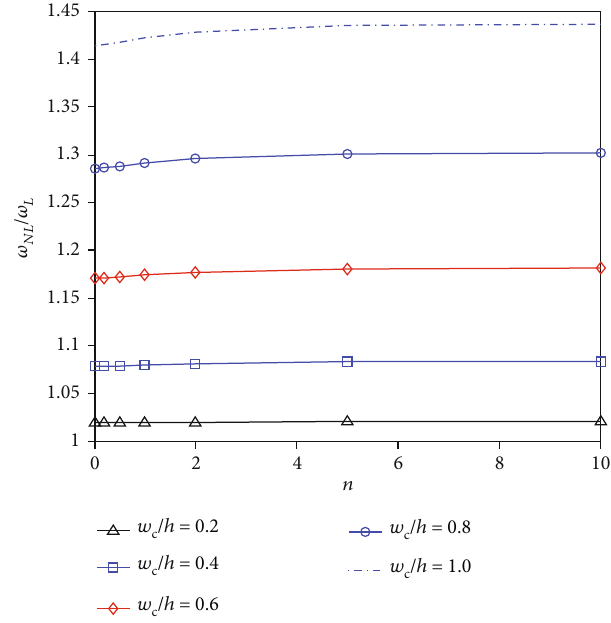
Figure 9: E ff ect of volume fraction index n , q = 1 , a / h = 10 , SSSS.